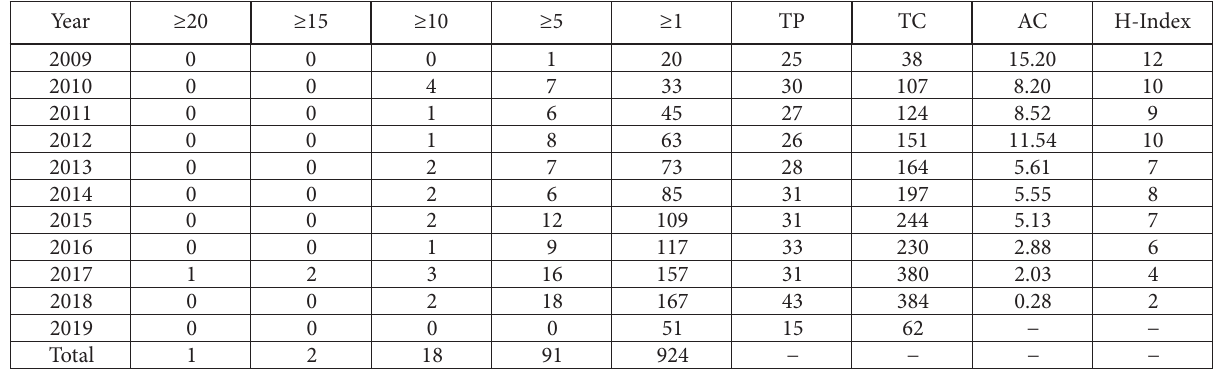
Table 2. Annual citation structure of the publications in the